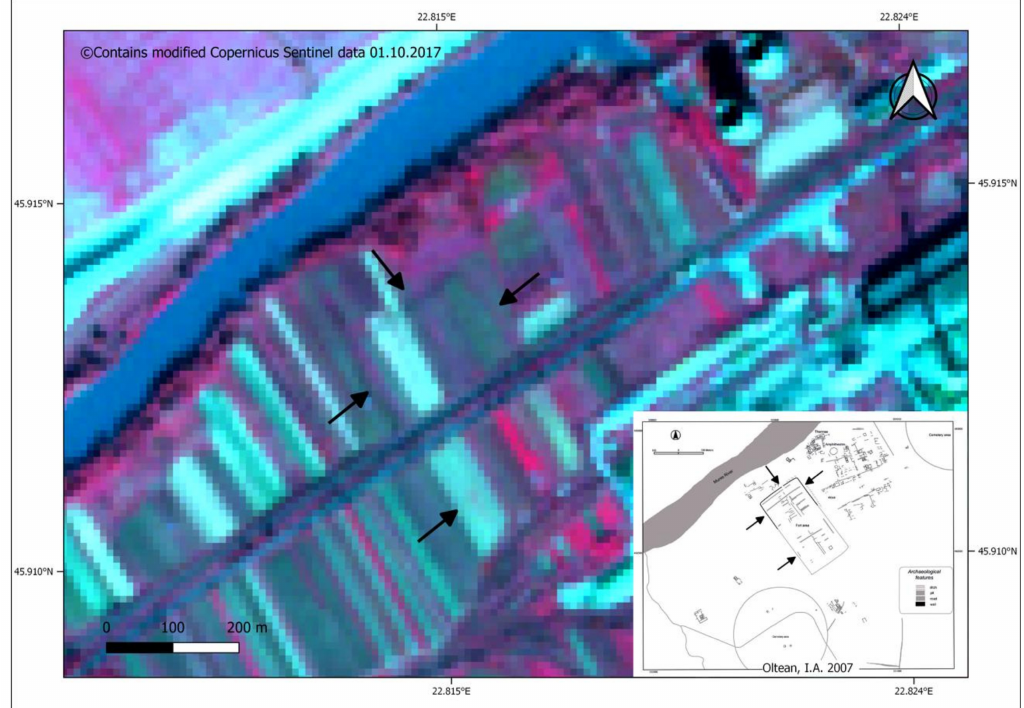
Figure 20. False colour composite of Sentinel–2 imagery for the Micia Roman fort. The highlighted features represent underground walls of the fort area. The identification of the buried structures was performed by correlating the satellite image with the fort map ( ©